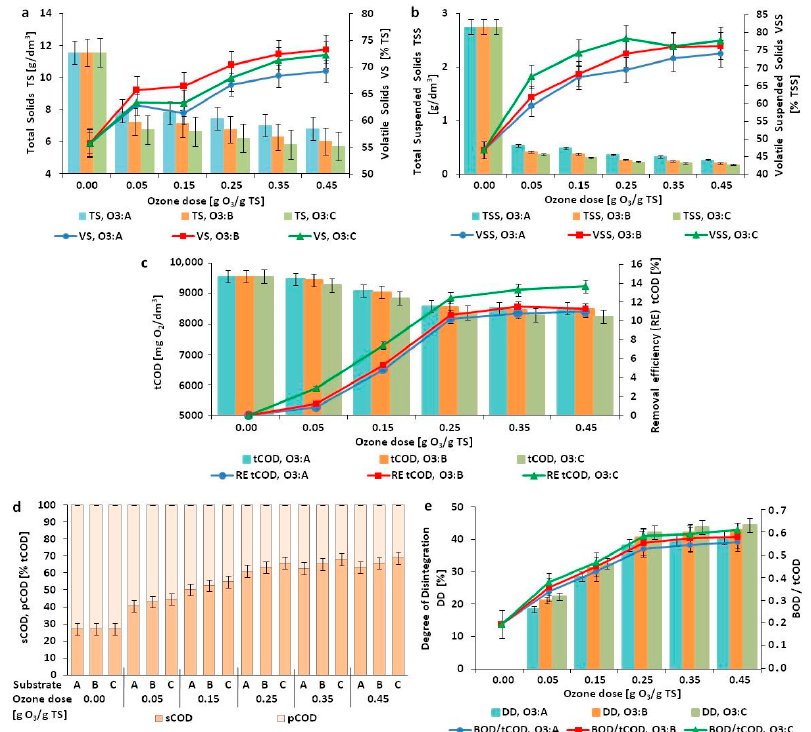
Figure 1. Effect of ozone dose and initial pH of digestate liquid fraction on concentration of TS and VS ( a ), TSS and VSS ( b ), tCOD ( c ); removal efficiency of tCOD ( c ); percentage of sCOD and pCOD in tCOD ( d ); degree of disintegration and BOD/tCOD ratio ( e ) during ozonation of digestate liquid fraction.